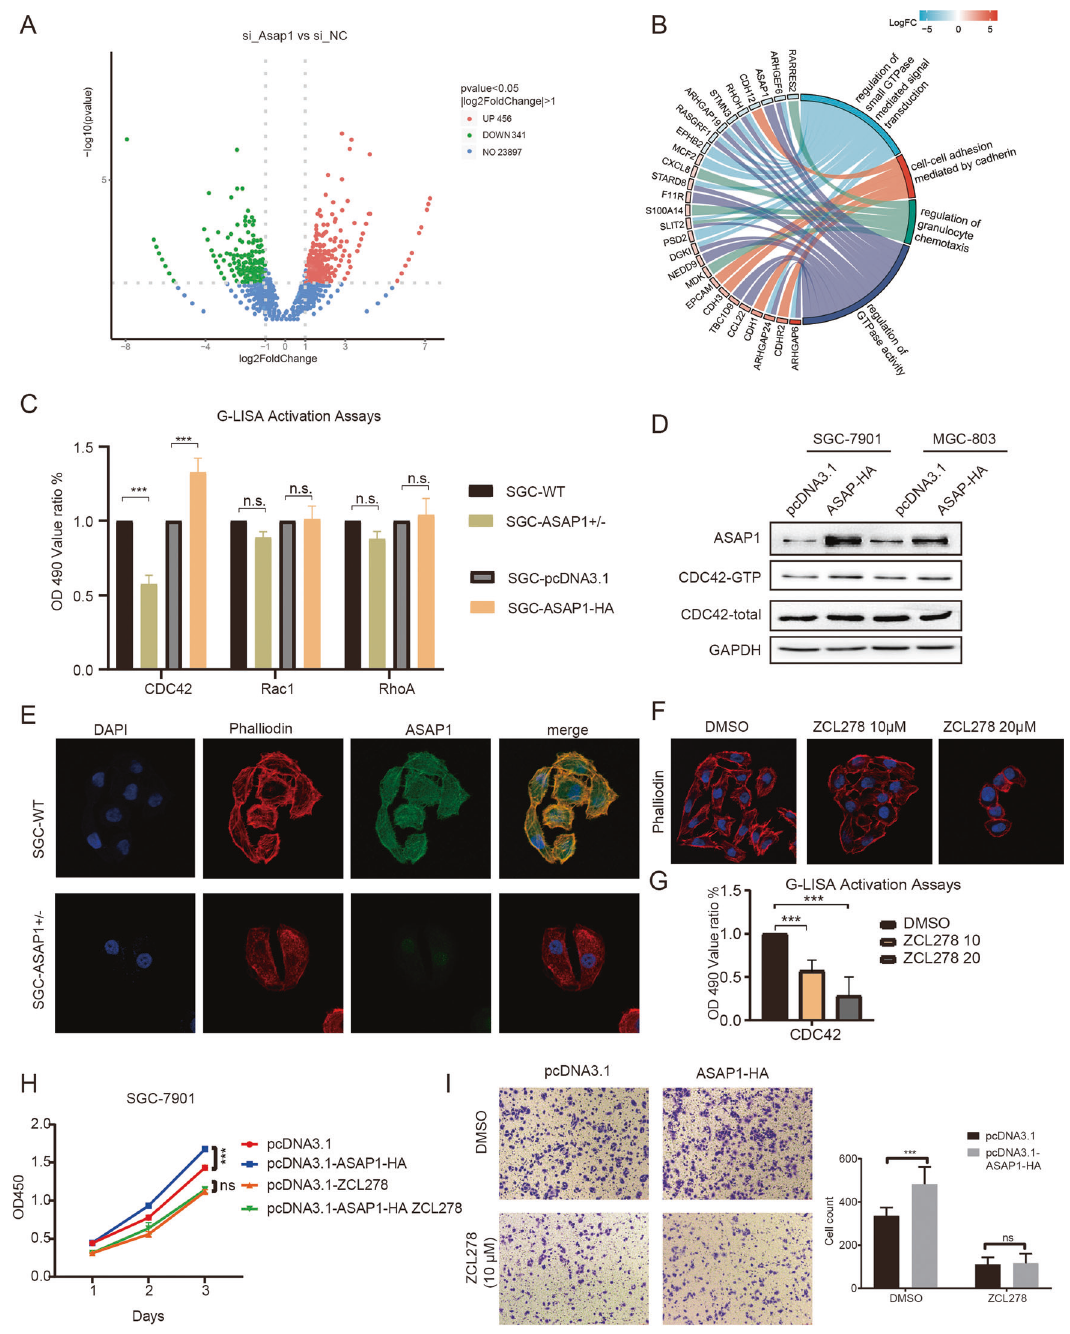
Fig. 5 ASAP1 mediates cytoskeleton assembly by regulating CDC42 expression in GC cells. A The RNA-seq of ASAP1-depletedGC cell and a volcano plot showing the differential genes. B KEGG pathway analysis showing enrichment of differential gene. C The whole cell lysates were extracted from SGC-7901 cells expressing ASAP1-HA or from ASAP1 + / − SG-7901 cells to measure CDC42, RAC1, RALA and RhoA GTPase activity by G-LISA activation assay. D The whole cell lysates prepared from either SGC-7901 or MGC803 cell expressing ASAP1-HA were used for CDC42 activation assay followed by western blotting. E Combined phalloidin staining for F-actin (red) and ASAP1 (green) immuno fl uorescence. Nuclei were counterstained with DAPI (blue). In ASAP1 + / − SGC-7901 cells, the fi lamentous pseudopodia disappeared and cytoskeleton depolymerized. F SGC-7901 cells were treated with CDC42 inhibitor ZCL278 and combined phalloidin staining for F-actin (red). The fi lamentous pseudopodia disappeared and cytoskeleton depolymerized. G SGC-7901 cells were treated with CDC42 inhibitor ZCL278 and the whole cell lysates were extracted to measure CDC42 GTPase activity by G-LISA activation assay. H The proliferation of SGC- 7901 cells transfected with pcDNA3.1, SGC-7901 cells transfected with pcDNA3.1-ASAP1-HA, SGC-7901 cells treated with ZCL278 or SGC-7901 cells transfected with pcDNA3.1-ASAP1-HA followed by treated with ZCL278 was determined by CCK-8. I The migration of various types of cells described in H was determined by Transwell assays.